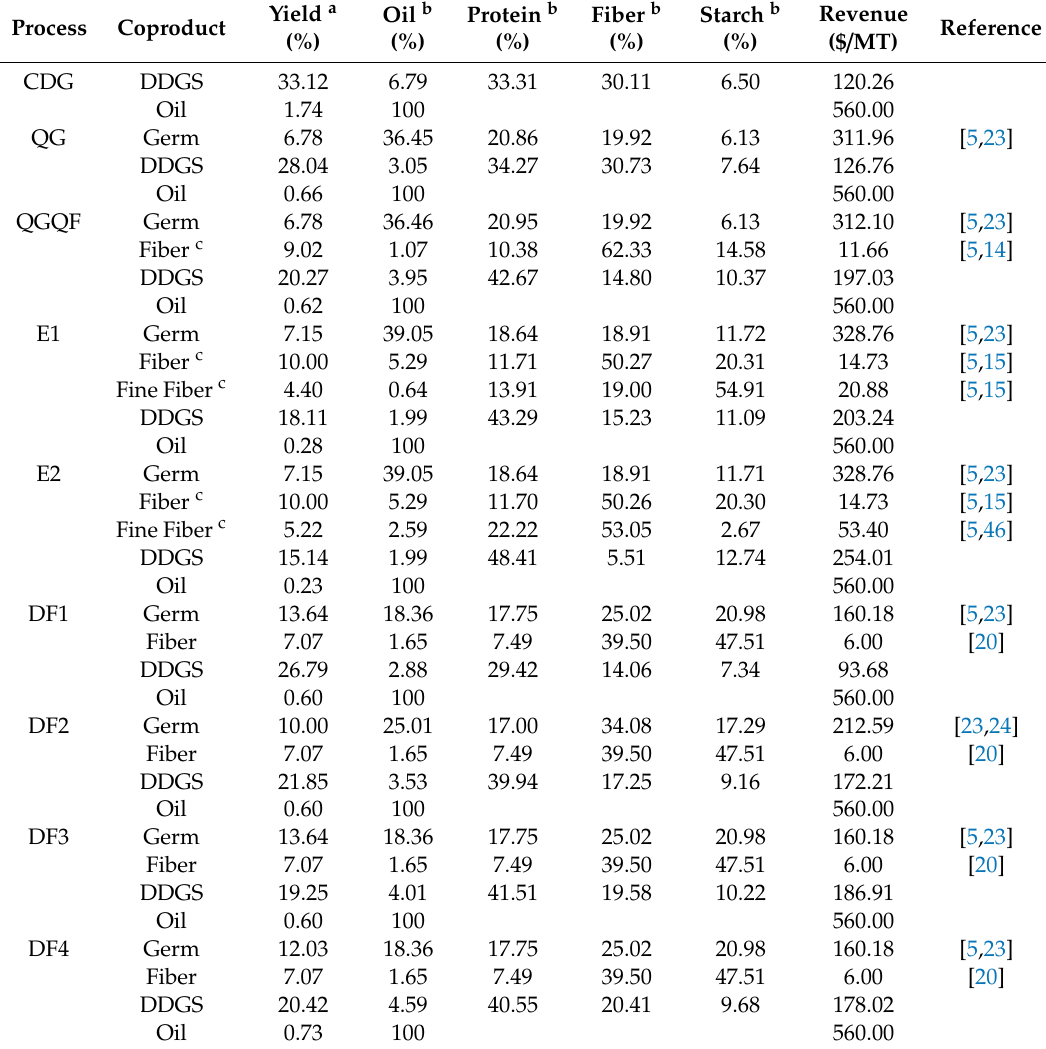
Table 2. Yield, composition and prices of coproducts in modified dry grind